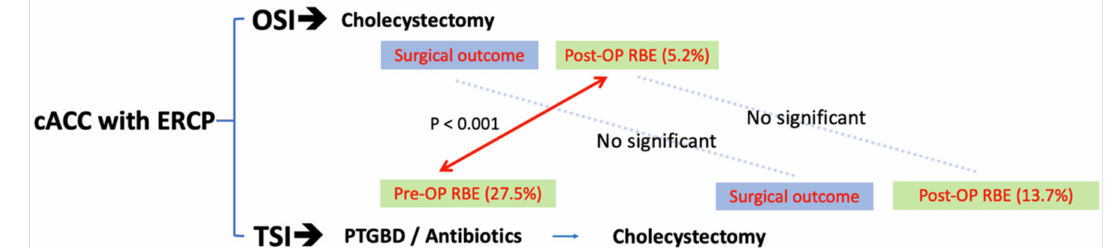
Figure 3. Graphic summary of results of present work. cACC, concurrent acute cholecystitis and cholangitis; OSI, one-stage intervention; TSI, two-stage intervention; RBE, recurrent biliary event; PTGBD, percutaneous transhepatic gallbladder